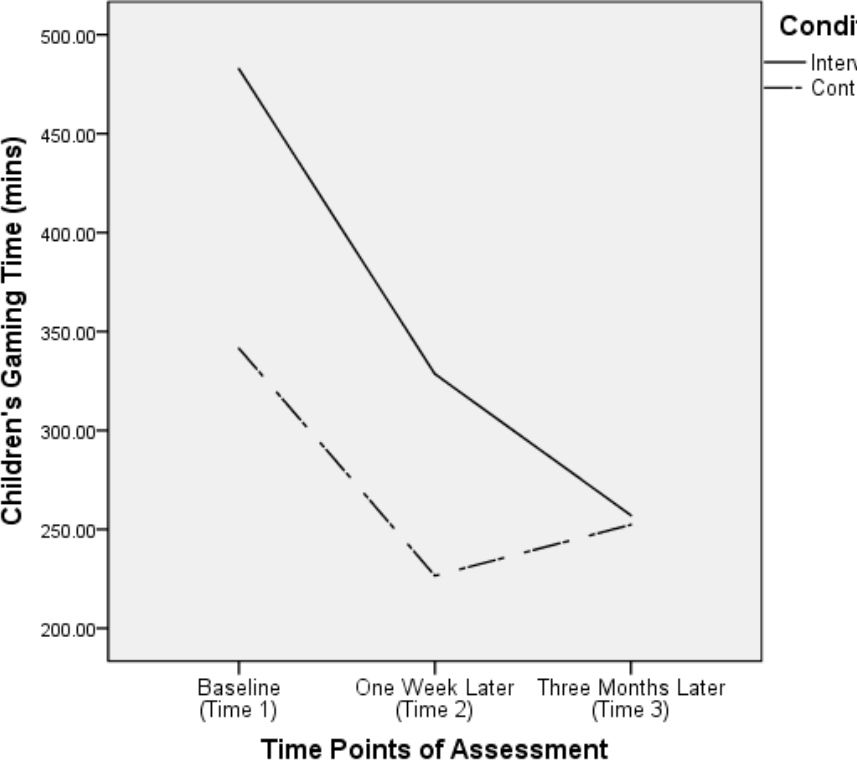
Figure 1. Parent report of children’s gaming time (in minutes) by time and condition.